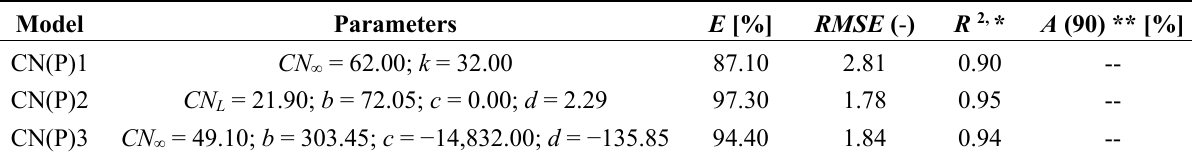
Table 5. P - CN obs parameters of different models and the quality of calculation-observation fit in the watershed D.